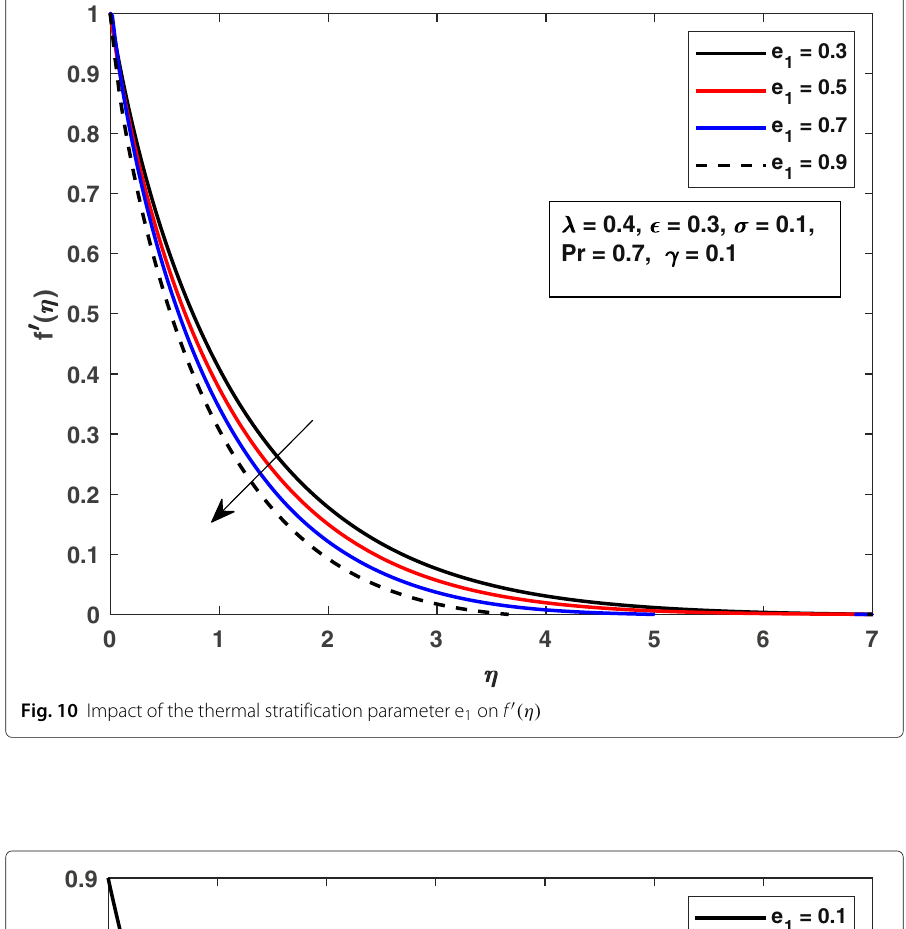
Fig. 10 Impact of the thermal stratification parameter e 1 on f (cid:6) (η)